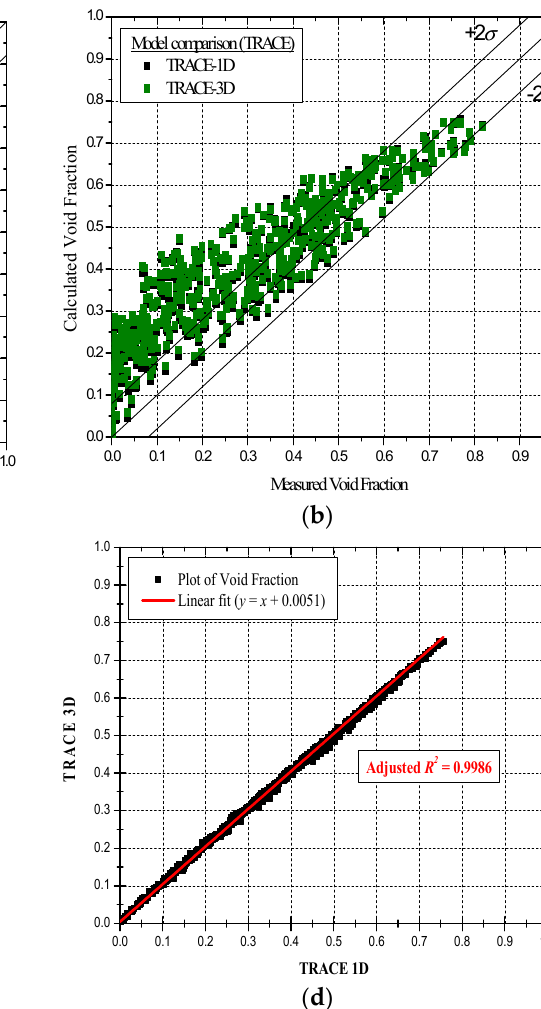
0.0 0.1 0.2 0.3 0.4 0.5 0.6 0.7 0.8 0.9